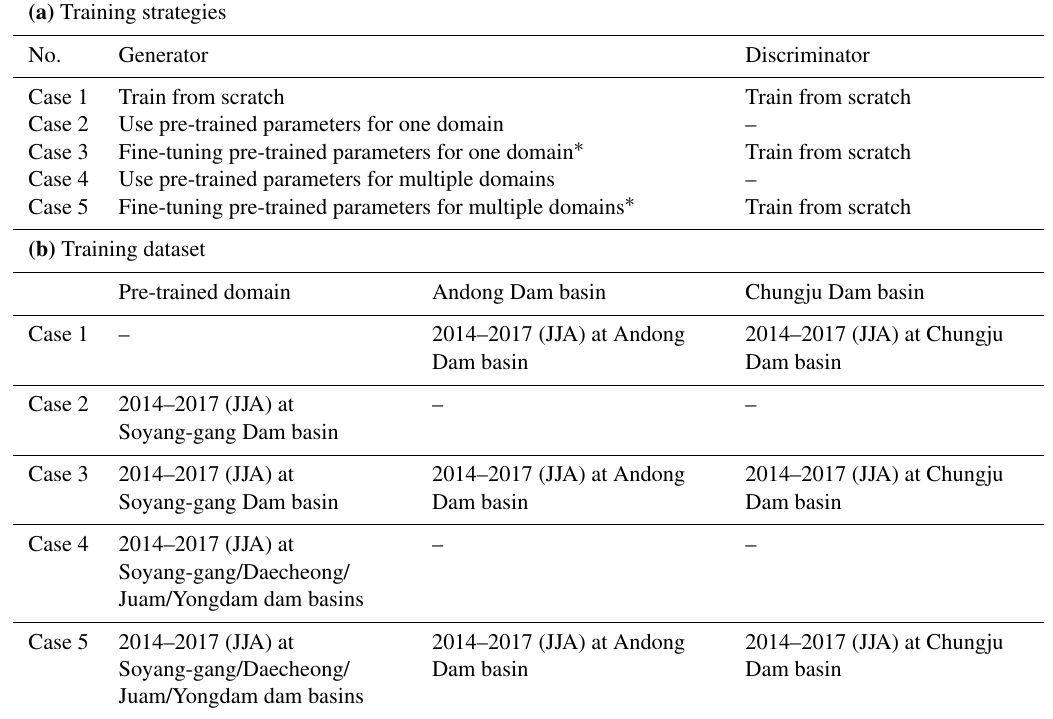
Table 3. Experimental design for transfer learning strategies to train the model with different domains. (a) Detailed training procedure of each strategy, (b) data used to train the model according to each strategy.